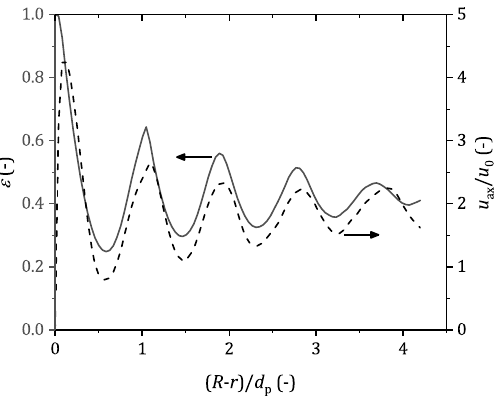
Figure 1. CFD simulation result of the radial void fraction distribution and radial profile of the averaged normalized axial velocity for a packing of spherical particles ( N =